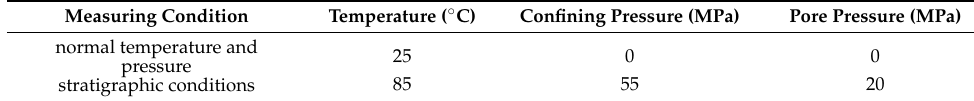
Figure 3. Schematic diagram of complex resistivity measurement.